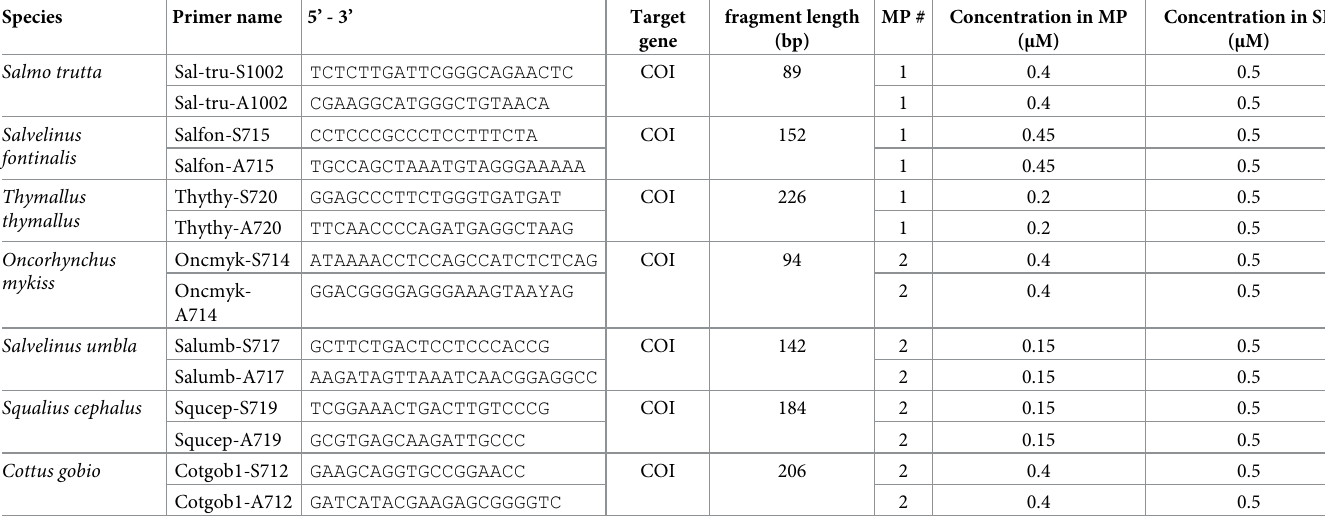
Table 2. The target fish species and the associated species-specific primer